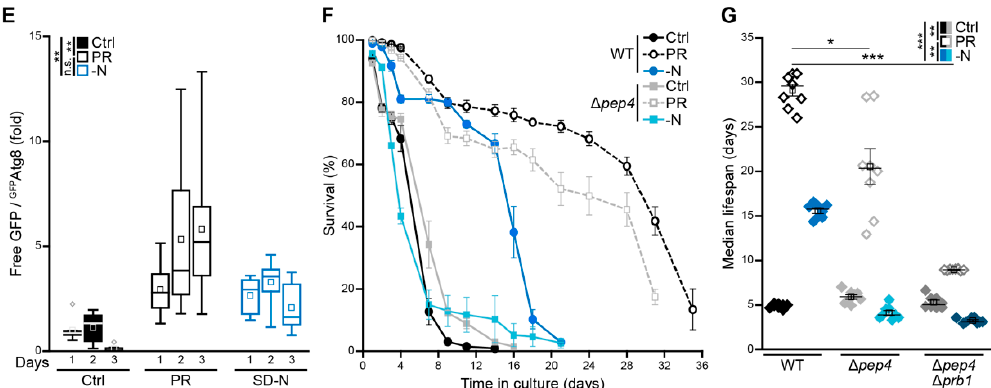
Figure 3. Phosphate exhaustion results in a strong induction of autophagy. ( A , B ) Immunoblot analysis ( A ) and corre- sponding densitometric quantification ( B ) of GFP Atg8 processing in protein extracts from WT cells harboring endogenously GFP-tagged Atg8 grown in standard (Ctrl) or phosphate-restriction (PR) media. Blots were probed with antibodies directed against GFP, and the ratio free GFP/ GFP Atg8, indicative of autophagic flux, is depicted; n = 3. ( C ) Microscopic analysis of WT cells endogenously expressing GFP Atg8, as well as Vph1 RedStar , to visualize vacuoles grown for 1 or 3 days on Ctrl or PR media. Scale bar represents 3 µ m. ( D , E ) Immunoblot analysis ( D ) and corresponding densitometric quantification ( E ) of GFP Atg8 processing in protein extracts from WT cells harboring GFP-tagged Atg8 subjected to phosphate restriction (PR), nitrogen starvation ( − N) or standard conditions (Ctrl). Blots were probed with antibodies directed against GFP, and the ratio free GFP/ GFP Atg8, indicative of autophagic flux, is depicted; n = 8. ( F ) Survival during chronological aging of WT and ∆ pep4 cells grown on Ctrl, PR or − N medium. Cell death was determined via flow cytometric analysis of PI staining; n ≥ 4. ( G ) Median lifespan of cells shown in ( F ) including ∆ pep4 ∆ prb1 cells; n = 8. For statistical analysis, two-way ANOVA ( B , E ) and Welch–ANOVA ( G ) were used. * p < 0.05, ** p < 0.01 and *** p < 0.001; ns not significant.